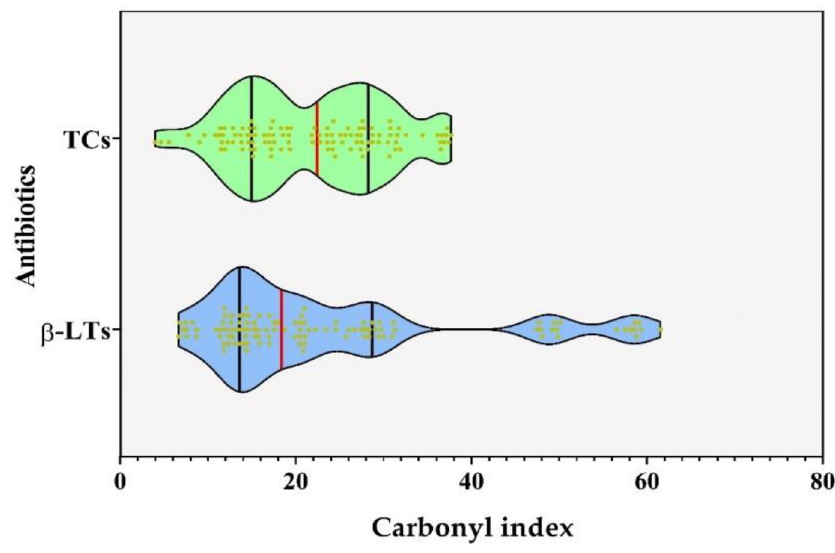
Figure 5. Carbonylation induced by assayed antibiotics (TCs and β -Lts) on main chicken breast protein fractions. The medians and quartiles are showed as black and red lines in the violin boxes, respectively.